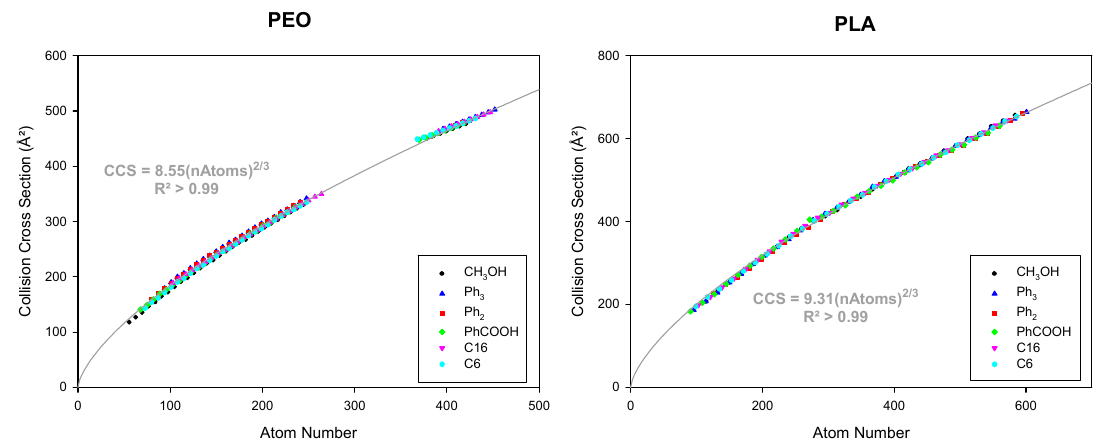
Figure 4. Evolution of the collision cross section as a function of the number of atoms for singly and doubly charged globular ions of pristine and functionalized PEO and PLA. Fittings were performed using the equation CCS = A (cid:48) nAtoms 2 3 ; the equations and regression coe ffi cients of the two fits are shown.